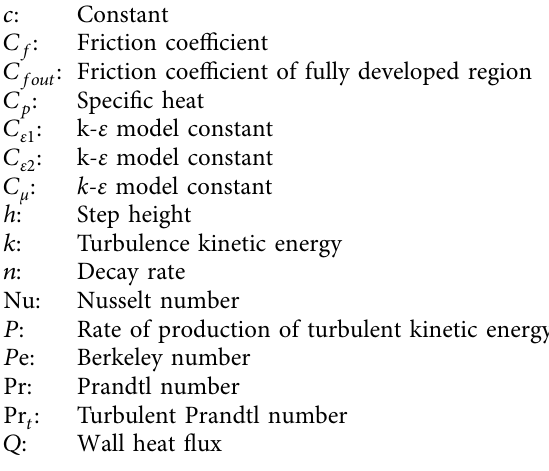
Figure 14: Axial uncertainty quantification of Nu with 6s